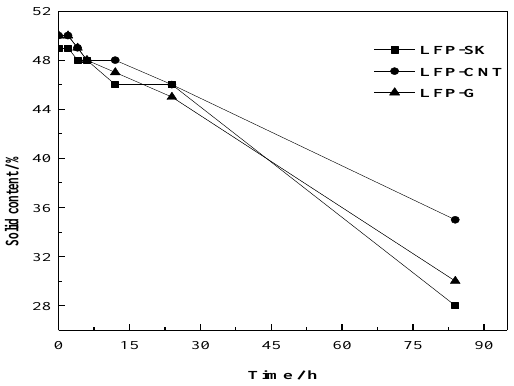
Figure 4. Changes in solid contents over time.